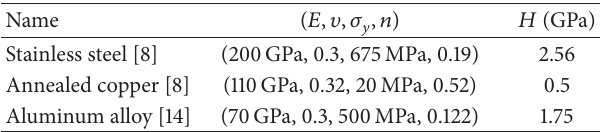
Table 1: Mechanical properties of the elastoplastic materials consid- ered in this